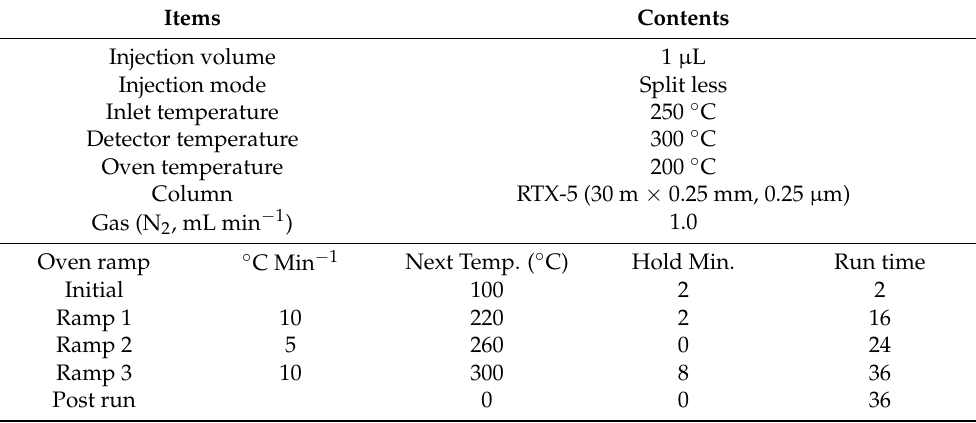
Table 2. Analytical conditions for endosulfan in soils (GC- µ ECD, Hewlett Packard, Palo Alto, CA, USA,